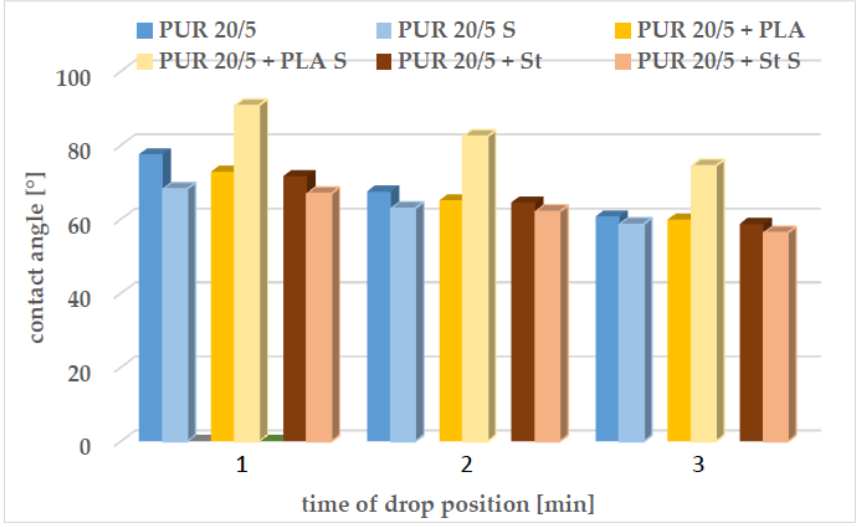
Figure 5. Contact angle (0, 1 and 3 min from the drop position) of the PUR 20/5, PUR 10/5 + PLA and PUR 20/5 + St surfaces before and after 36 weeks of exposure to